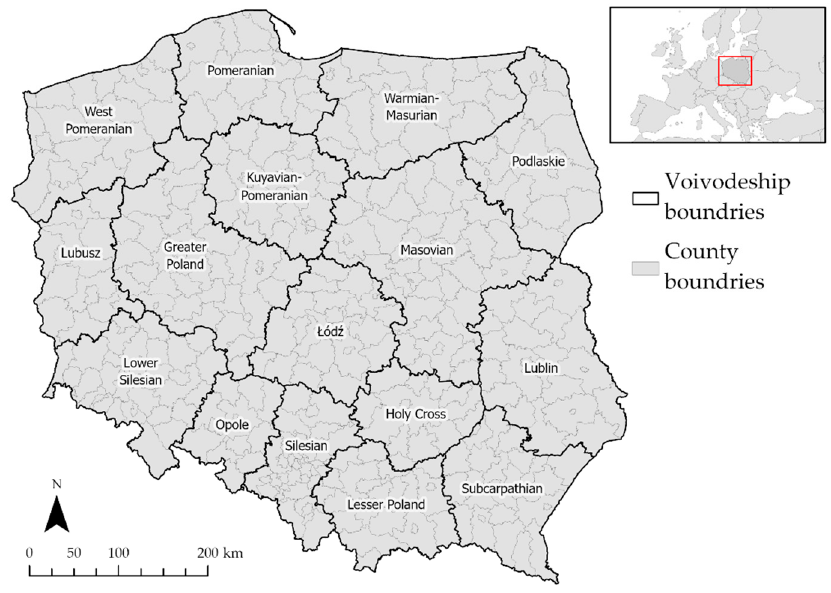
Figure 1. Study area. Source: own elaboration using ArcGIS Pro 2.9 by